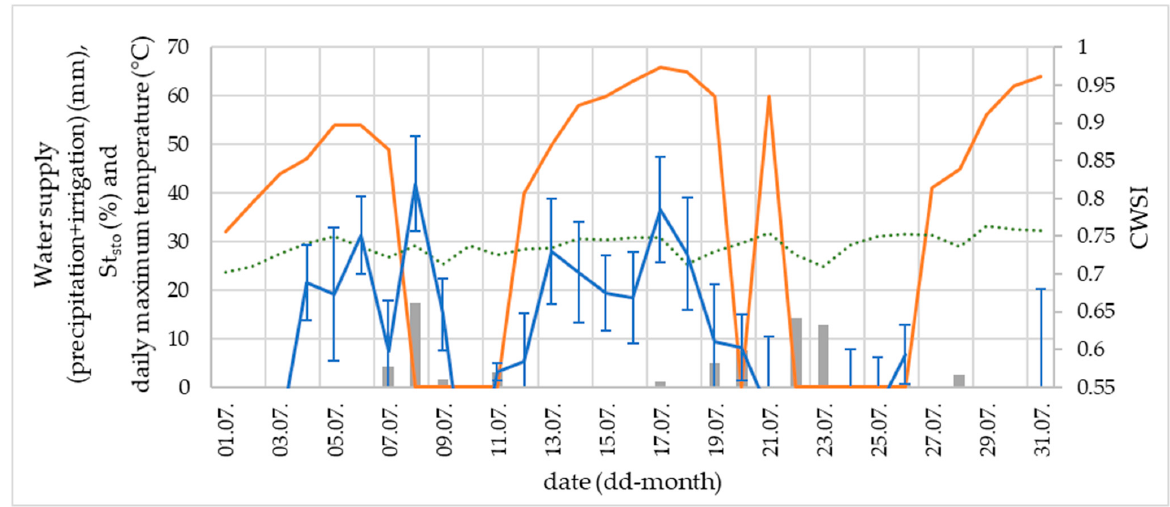
Figure 6. Comparison of water stress-related, simulated Ststo (percent water stress inducing stomatal closure–AquaCrop) (orange), and measured CWSI values (blue) in the treatment with severe stress. Error bars represent the standard error of CWSI values. Grey columns refer to the irrigation and rainfall events (mm) and green dotted line refers to the daily maximum temperature.